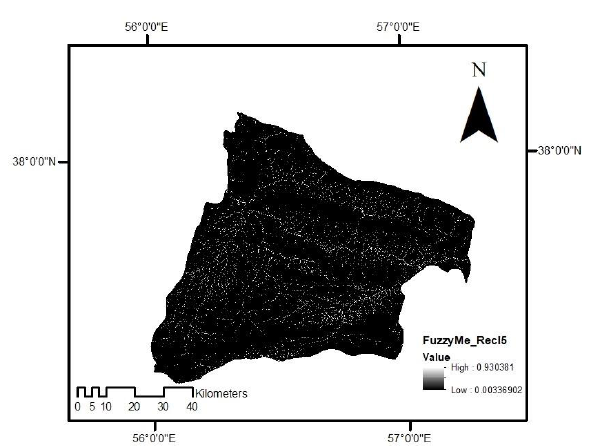
Figure 8. Using Large membership function for TWI layer